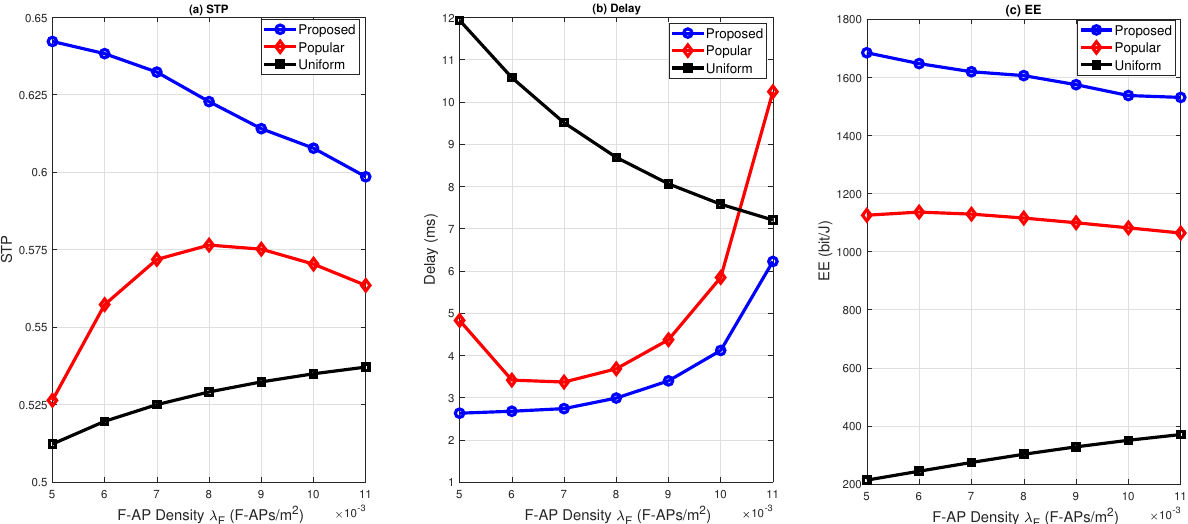
Figure 8. STP, delay, and EE versus F-AP density when M = 20 contents, λ U = 0.1 users/m 2 , λ C = 0.0001 C-APs/m 2 , R = 150 m, γ = 0.8, α = 4, P F = 30 dBm, P C = 40 dBm, P s = 37 dBm, ρ = 15.13, W F = 100 MHz, W C = 500 MHz, T = 1 ms, and τ = 0.1